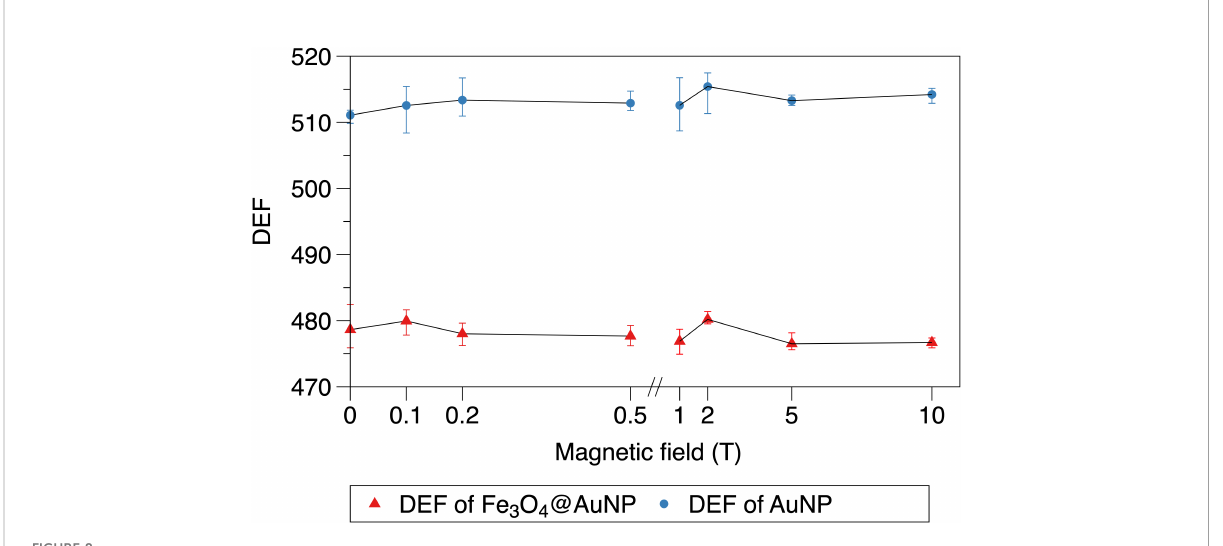
FIGURE 8 Relationship between magnetic fi eld and DEF of a single Fe 3 O 4 @AuNP and